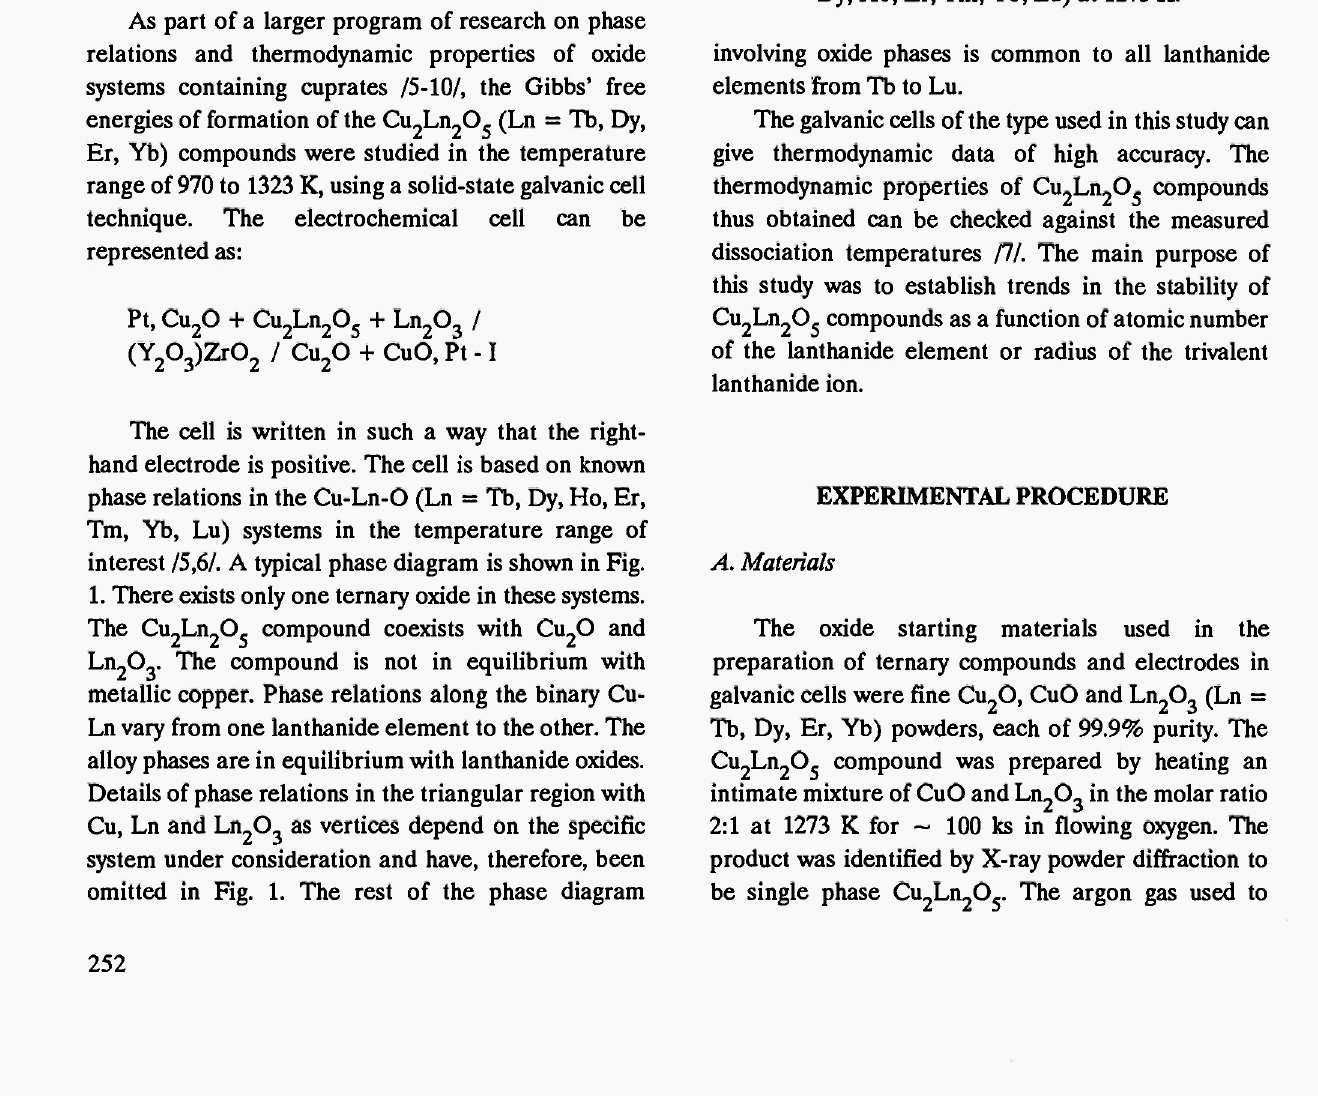
Fig. 1: A typical isothermal section of the phase diagram for the Ln-Cu-O system (Ln = Tb, Dy, Ho, Er, Tm, Yb, Lu) at 1273